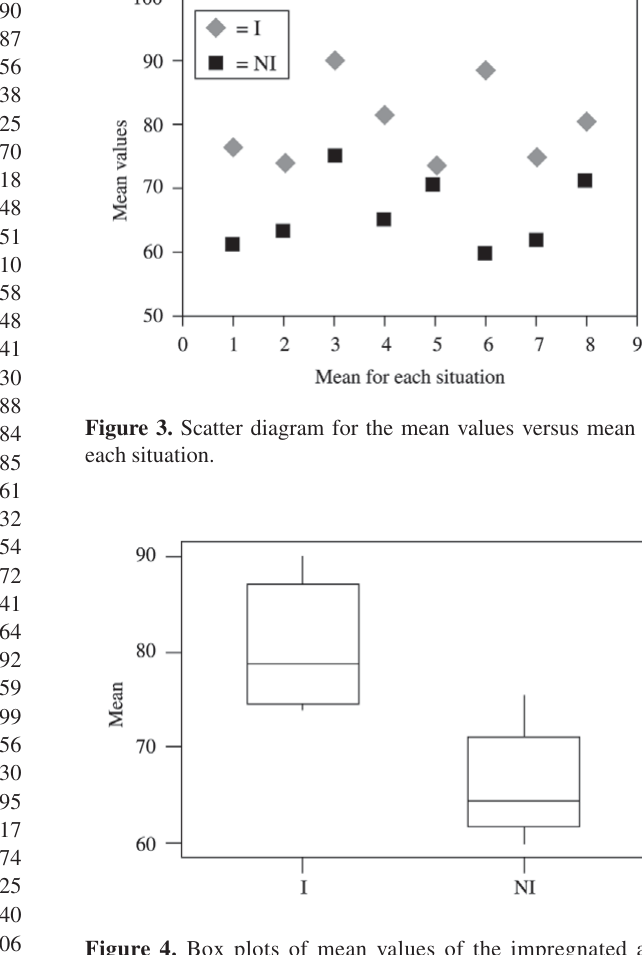
Figure 4. Box plots of mean values of the impregnated and nonimpregnated specimens